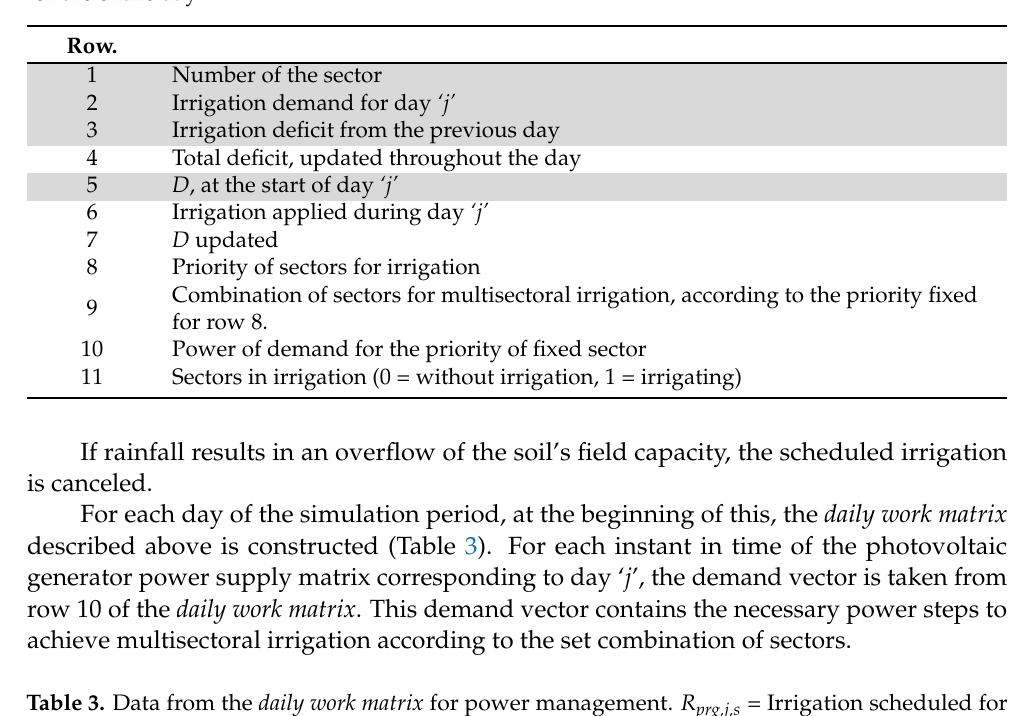
Table 2. Daily work matrix for day ‘ j ’. Both columns and sectors. The shaded rows have fixed values for the entire day.